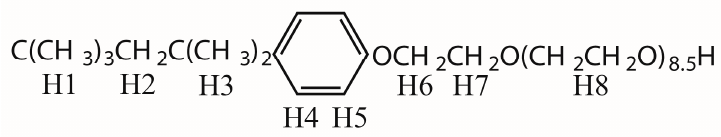
Figure 1. Formula and proton numbering of TX100.